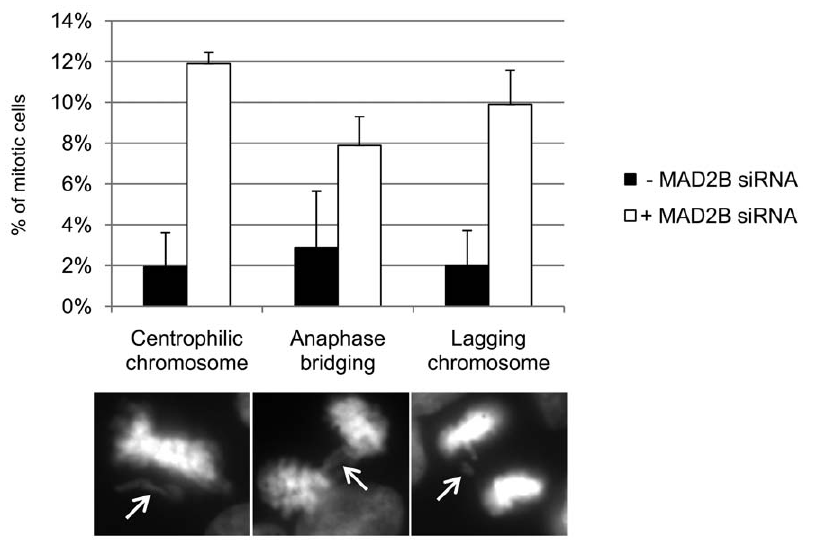
Figure 4. MAD2B depletion leads to mitotic defects. HEK293/T-REx/pSUPERIOR-MAD2B cells were transiently transfected with a H2B-RFP construct (see Materials and methods) and grown with or without tetracyclin ( + / 2 MAD2B siRNA), respectively. Subsequently, mitotic cells were scored for misaligned chromosomes. Percentages of cells with misalignments, such as centrophilic chromosomes, anaphase bridges and lagging chromosomes, are shown in the histogram. Black bars represent cells normally expressing MAD2B (- MAD2B siRNA; see Fig. 3, t=0), and white bars represent MAD2B depleted cells ( + MAD2B siRNA; see Fig. 3, t=4). In the lower panels examples of centrophilic chromosomes, anaphase bridges and lagging chromosomes are shown (arrows).